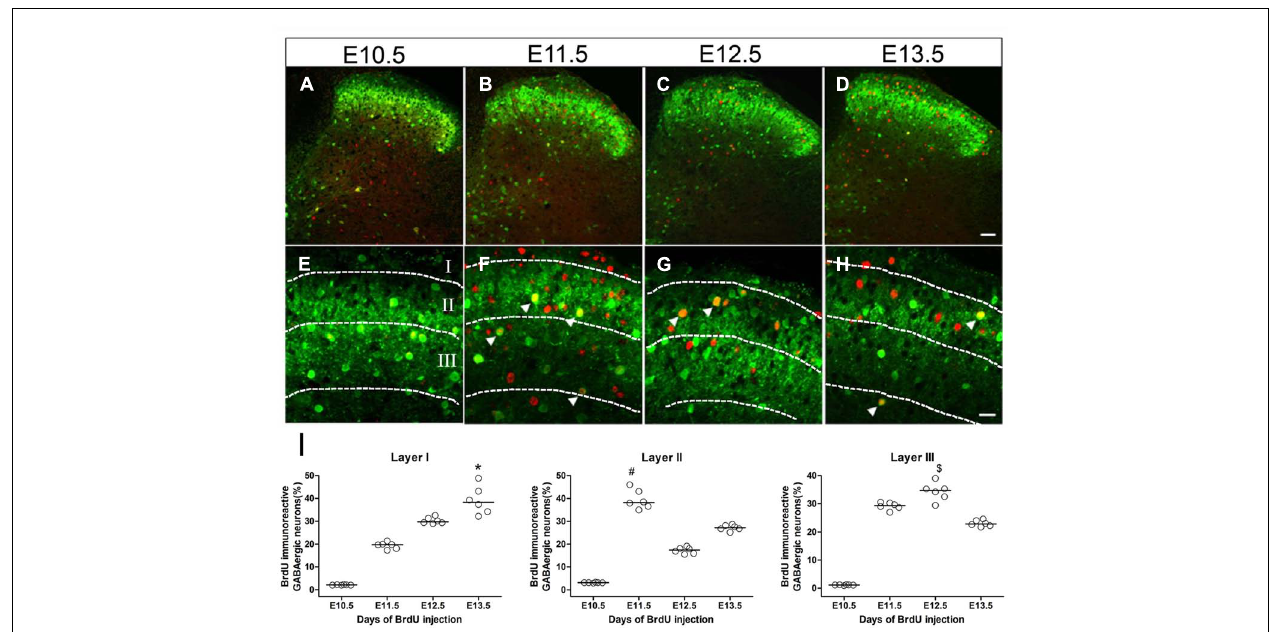
FIGURE 4 | Laminar distribution of double-labeled cells for GFP and BrdU in the superficial dorsal horn of GAD 67 -GFP knock-in mice injected with BrdU at E10.5 (A,E), E11.5 (B,F), E12.5 (C,G), and E13.5 (D,H), respectively. Double-labeled cells are indicated by white arrowheads (E–H) . (I) Data showing the percentage of double-labeled cells among GABAergic neurons in lamina I, lamina II, and lamina III of spinal cord at different developmental stages. The horizontal bar